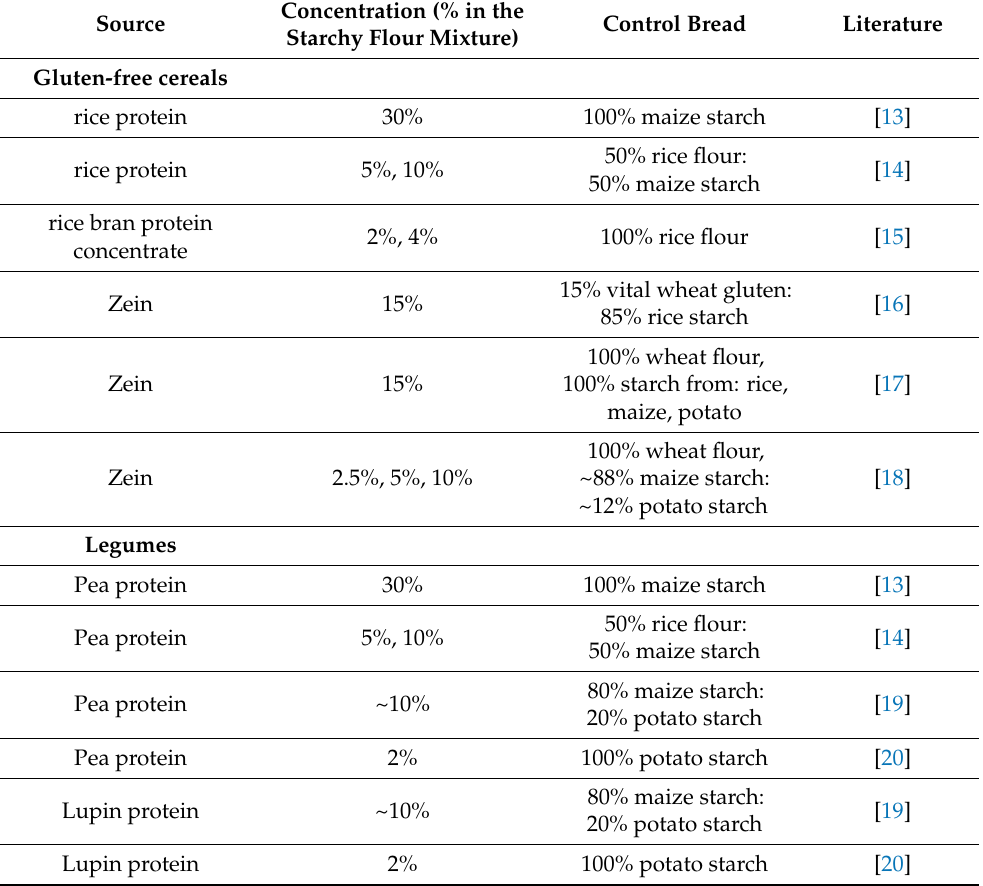
Table 1. Different high protein sources of vegetable origin reported in recent published literature to improve gluten-free